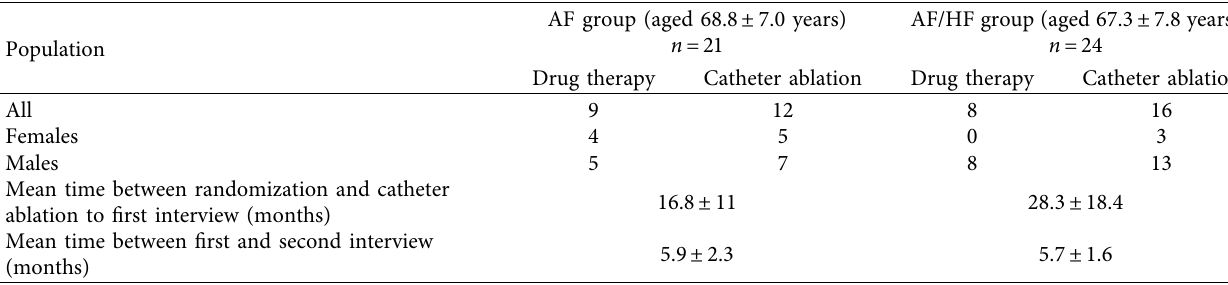
Figure 1: Study flowchart. AF � atrial fibrillation, HF � heart failure, and FU � follow-up. Table 1: Study